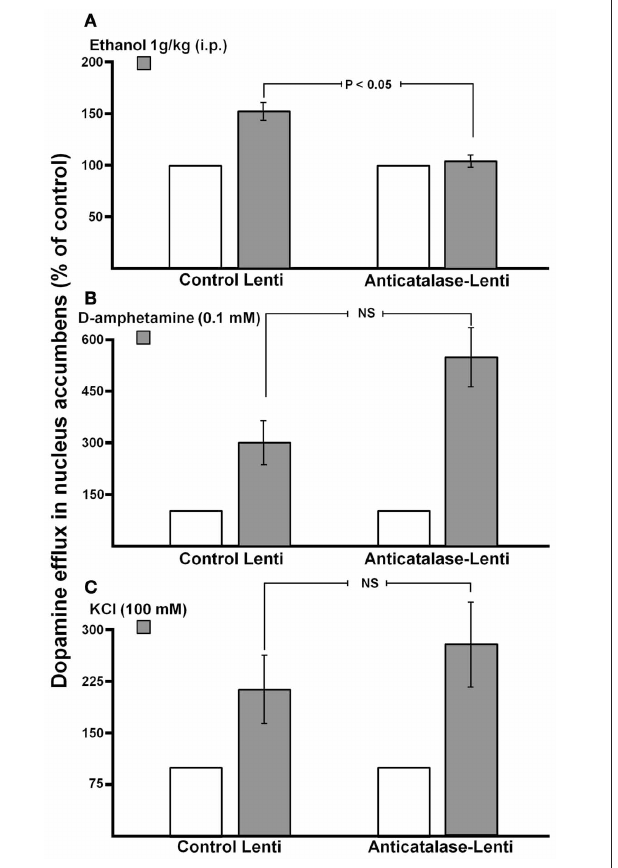
FIGURE 4 | Dopamine levels in the nucleus accumbens following acute ethanol administration. Effect of anticatalase vector administration into the ventral tegmental area on dopamine release monitored in the ipsilateral nucleus accumbens. (A) Inhibition by anticatalase-lentiviral vector of dopamine efflux into the microdialysis fluid of nucleus accumbens (shell) induced by the systemic administration of ethanol (1g/kg i.p.). (B) Anticatalase-lentiviral vector does not affect dopamine efflux into the microdialysis fluid of nucleus accumbens (shell) induced by d-amphetamine (0.1mM) or (C) Anticatalase-lentiviral vector does not affect dopamine efflux into the microdialysis fluid of nucleus accumbens (shell) induced by KCl (100mM) added to the microdialysis fluid. (From Karahanian et al.,